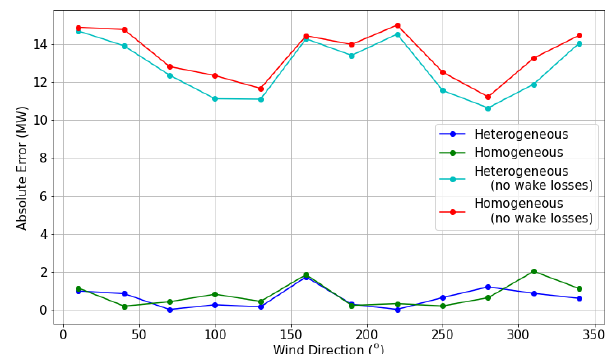
Figure 14. Absolute error in total farm power output calculated using the homogeneous and heterogeneous FLORIS models, with and without wake losses.